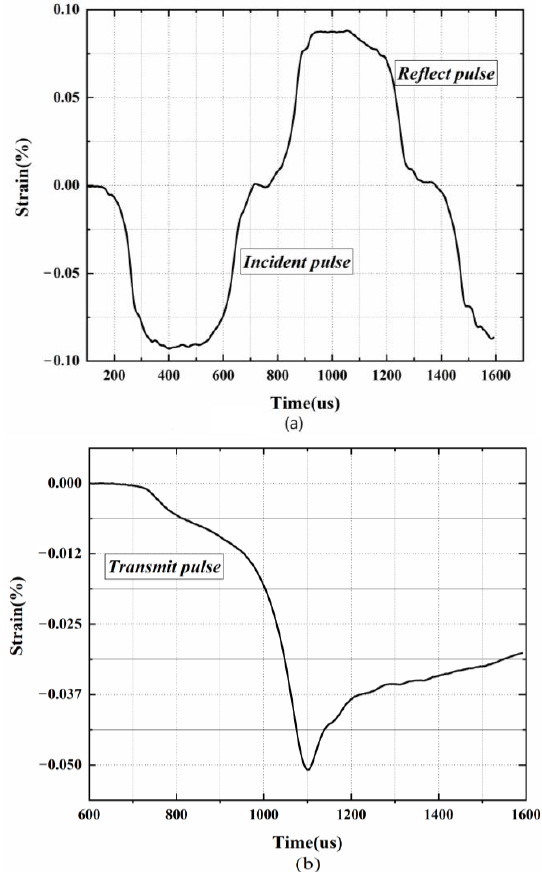
Figure 3. Typical PUME waveforms in SHPB experiments: ( a ) incident and reflected waves, ( b ) transmitted waves.